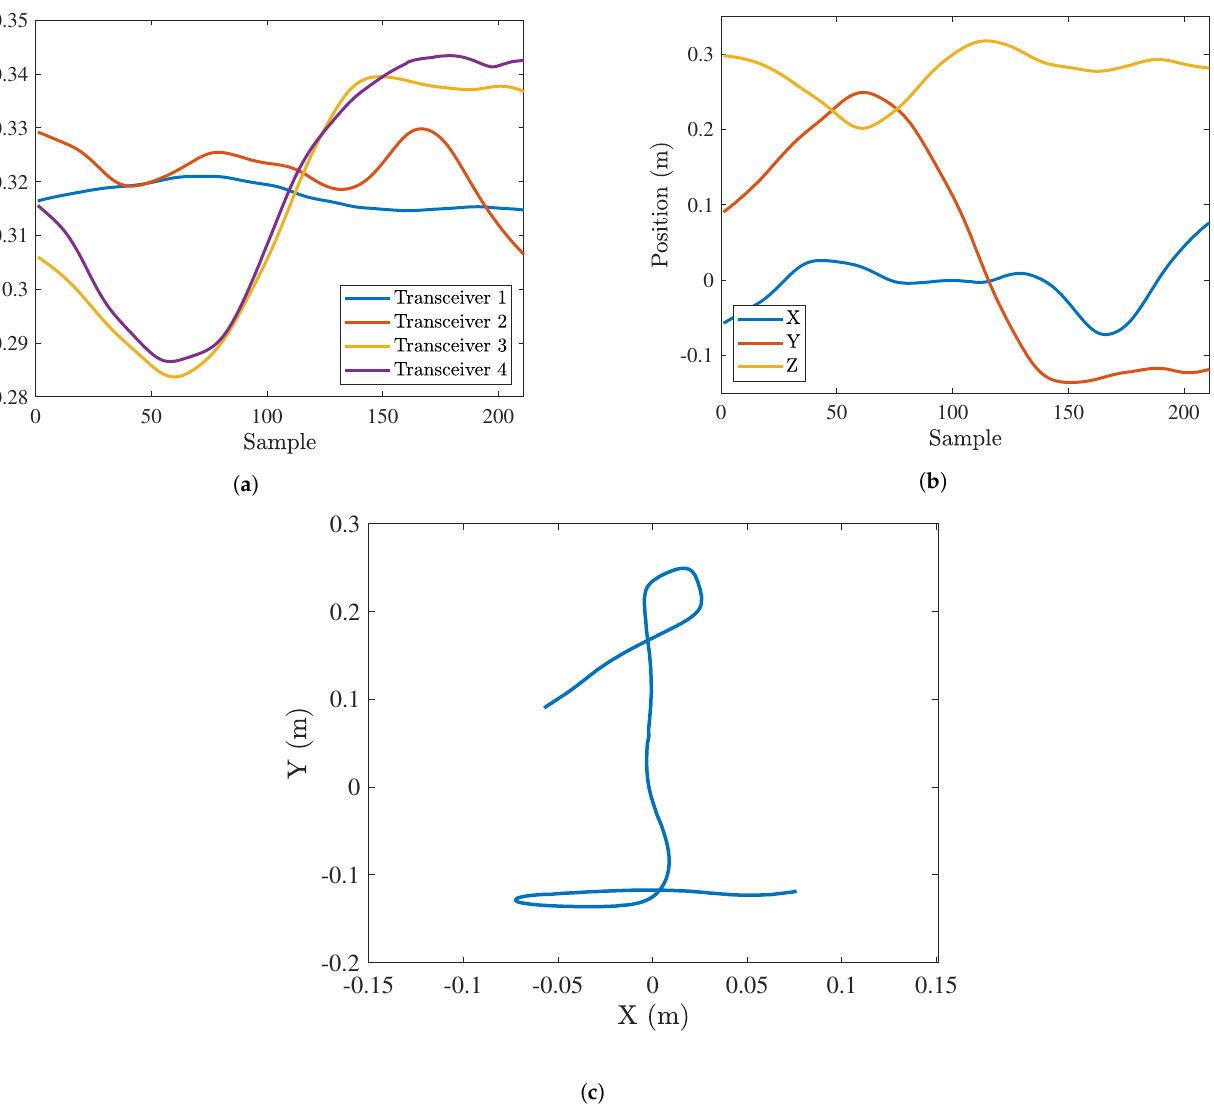
Figure 4. Different steps in the track estimation: Pairwise distances among transceivers and hand marker ( a ), 3D position time series ( b ), 2D projection ( c